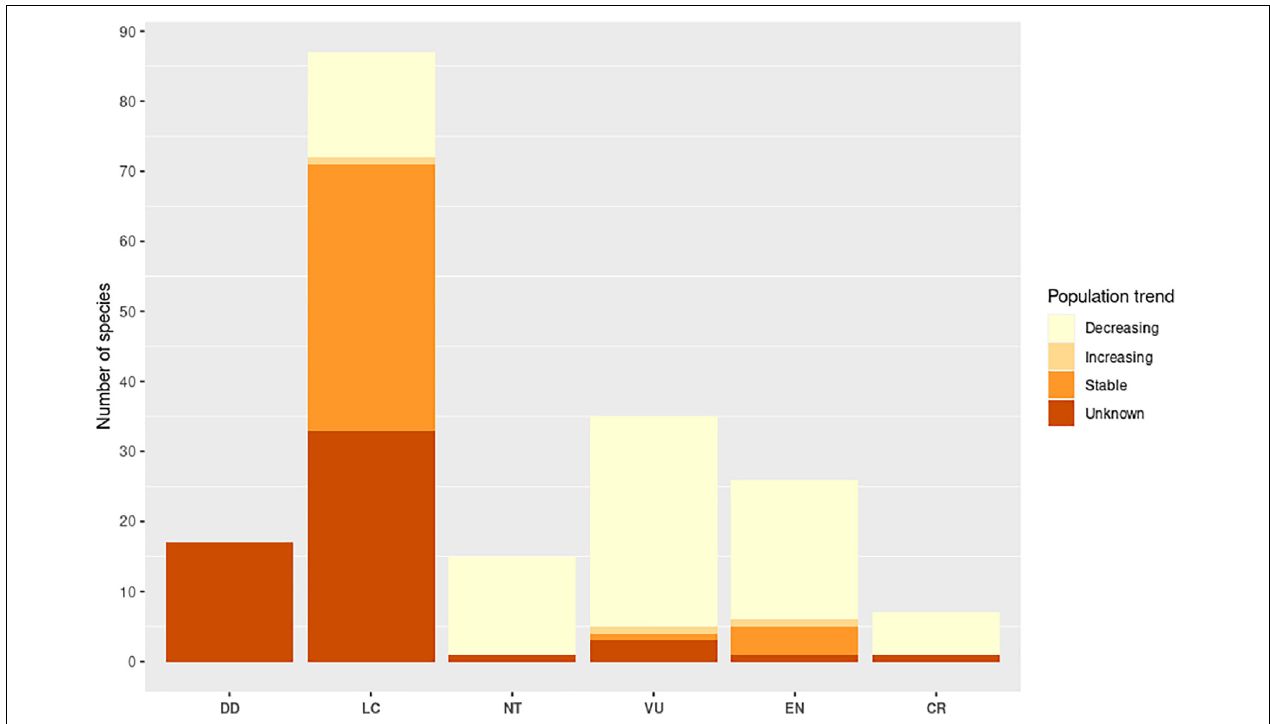
FIGURE 7 | IUCN Red List status and associated population trends of all assessed pteropodids